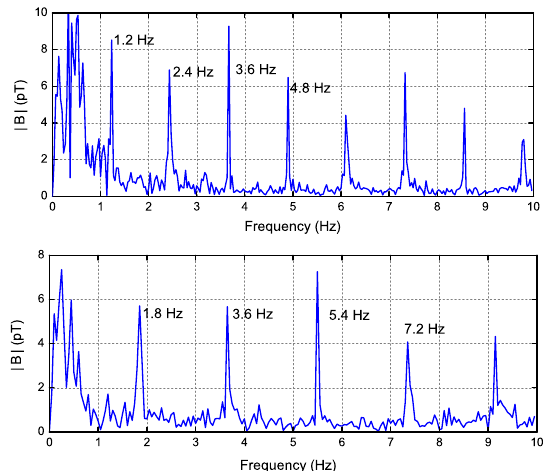
Figure 6. The spectrum signatures before ( upper ) and after ( lower ) the target’s acceleration.